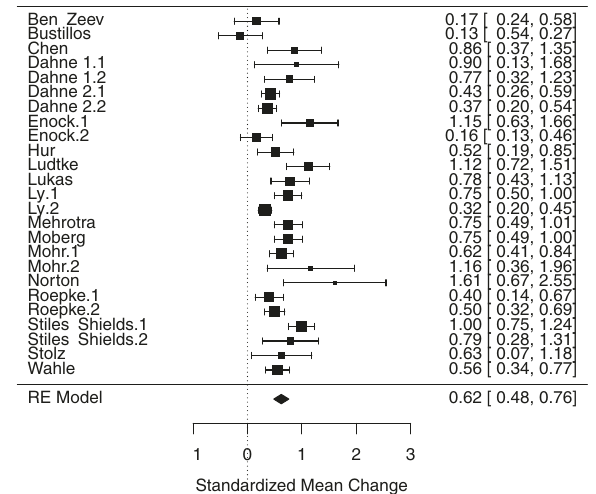
Fig. 2 Random effects meta-analysis of app ef fi cacy comparing pre-intervention to post-intervention change on an anxiety or depression symptoms. Forest plot of random effects meta-analysis of app ef fi cacy comparing pre-intervention to post-intervention change on an anxiety or depression